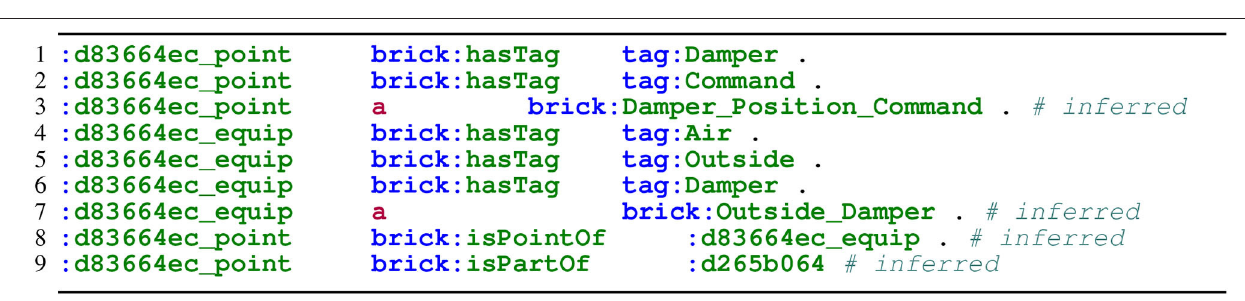
FIGURE 8 | Brick inference engine splits the entity into two components: the explicit point and the implicit outside damper